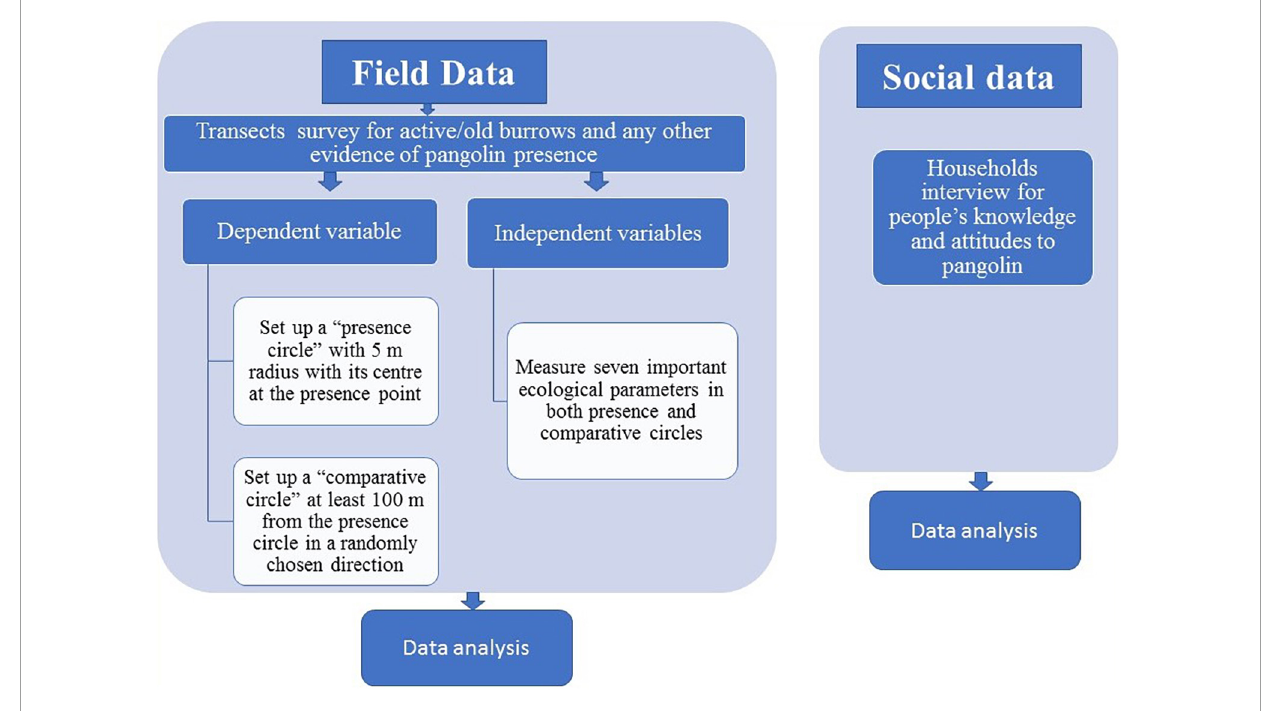
FIGURE1 A figure for a conceptual framework of the study.